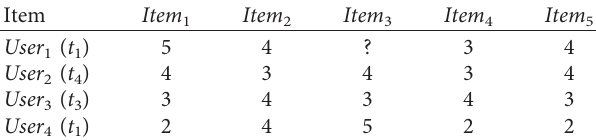
Table 1: User-item scores in different time